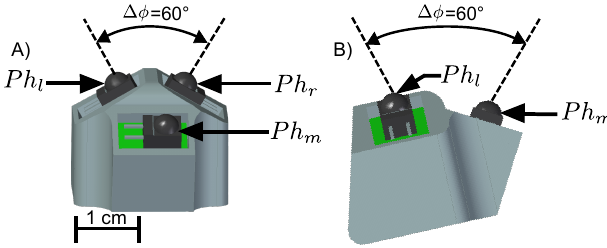
Figure 1. Computer-Aided Design of the optical sensor called HyperCube. Each side of the sensor consists of one photodiode soldered to a small printed circuit board ( Ph l , Ph r , Ph m respectively): ( A ) top view; and ( B ) side